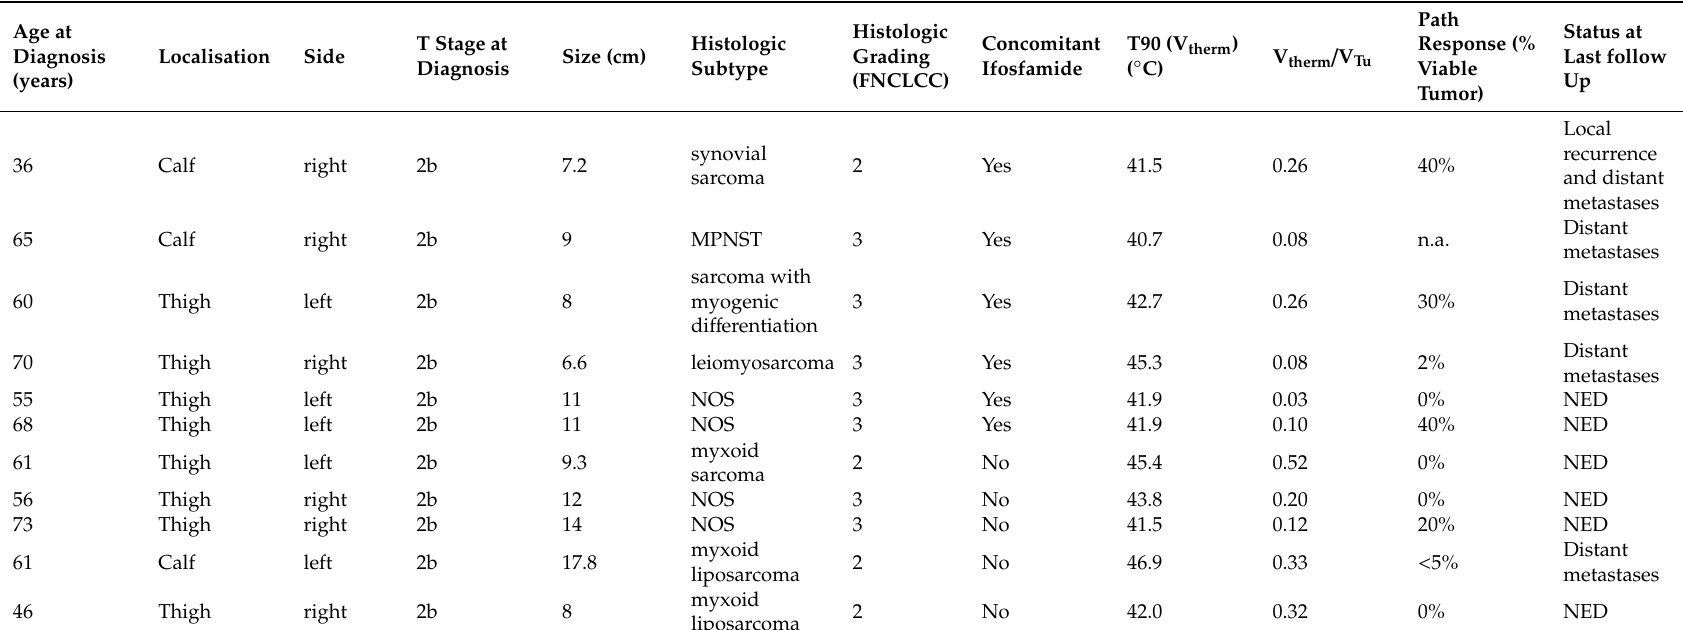
Table 1. Summary of